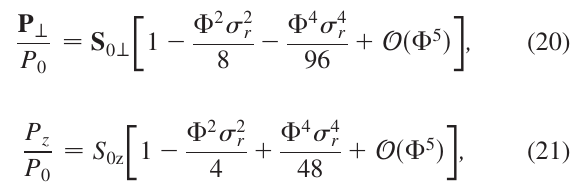
¼ 10 3 ) to 1 TeV ( (cid:3) 0 ¼ 0 : 9 . The solid black lines are =P z 0 0 . The dashed lines repre- 0 0